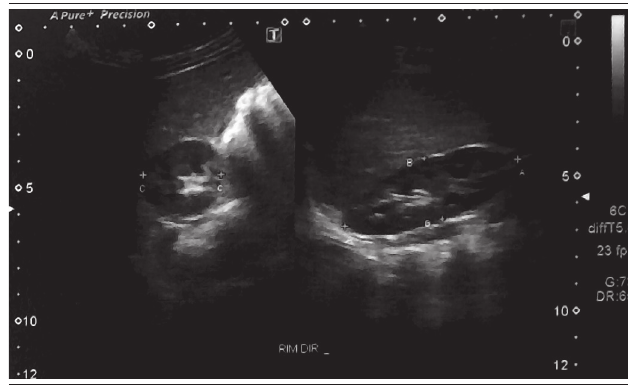
figurE 1 − Dynamic US of the right kidney showing kidney size US: ultrasonography.